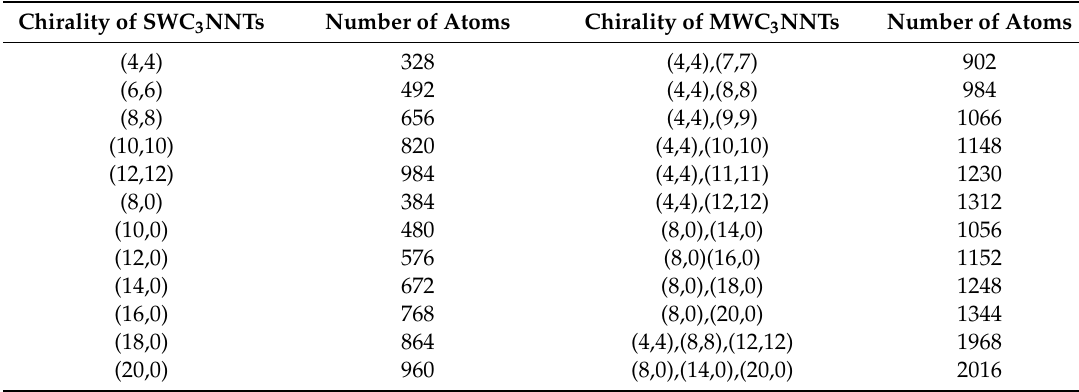
Table 1. Stoichiometry of single-walled C 3 NNTs (SWC 3 NNTs) and multi-walled (double-walled